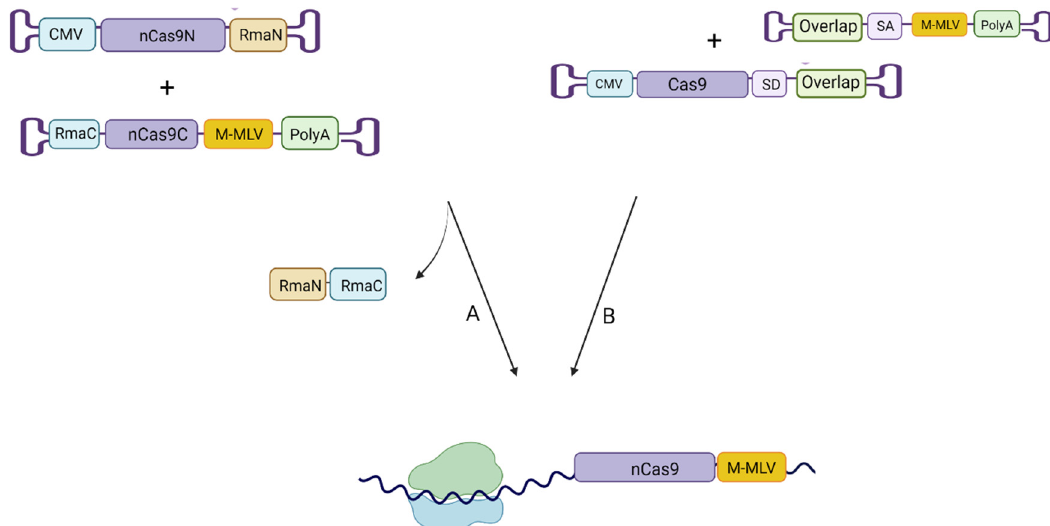
Figure 3. Example methods for dual vector delivery of large constructs. Delivery of a prime editing construct using dual vector approaches that employ ( A ) split Rma inteins or ( B ) hybrid approach. Created with BioRender.com (accessed on 22 August 2022).